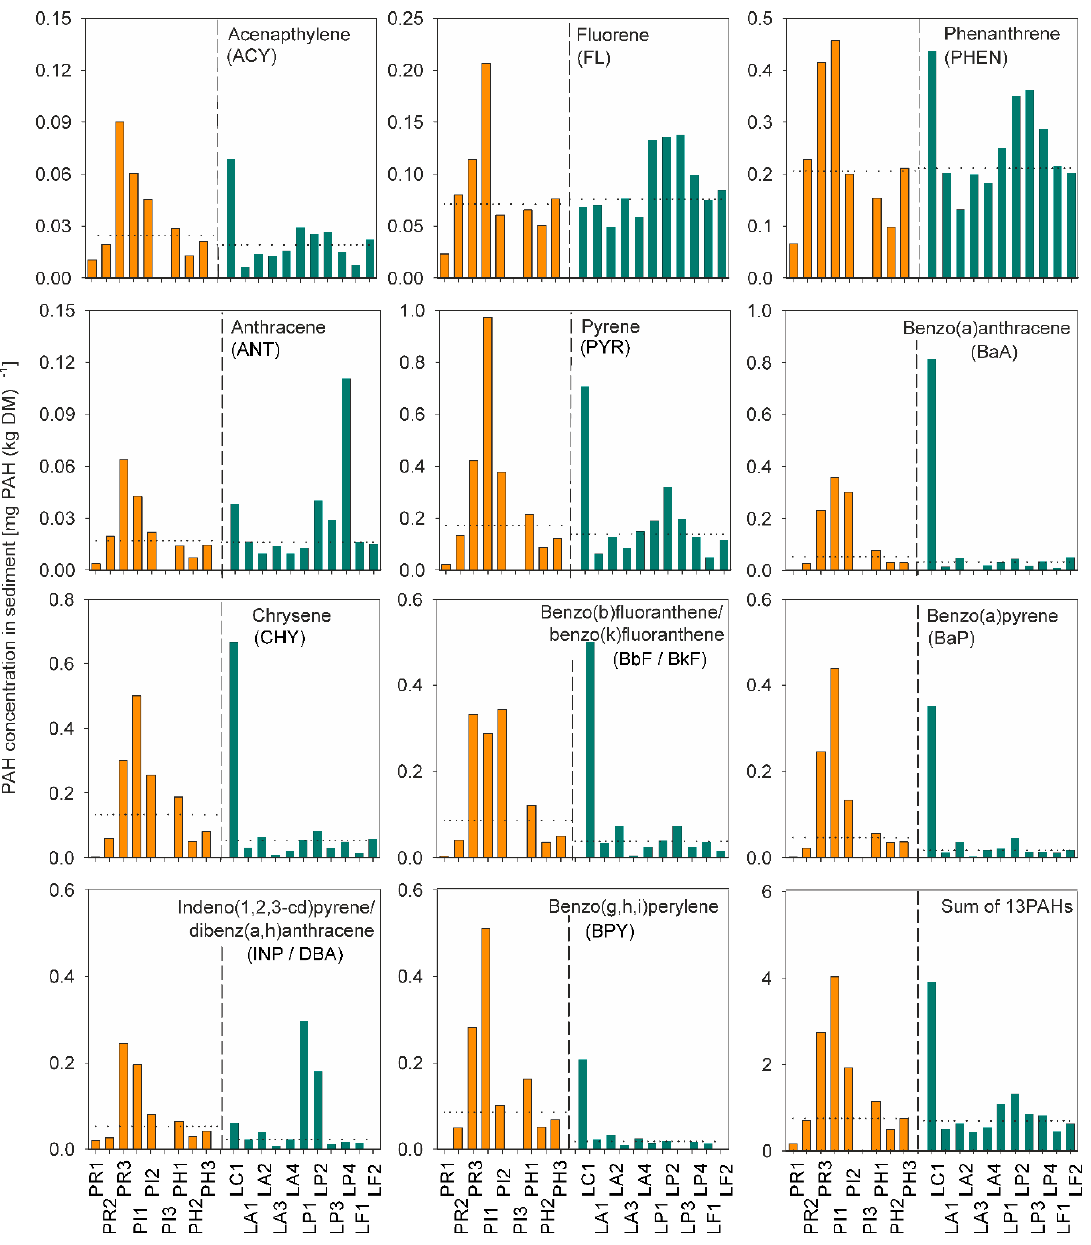
Figure 2. Polycyclic aromatic hydrocarbons (PAH) concentrations in sediments of the SWRPs (orange bars) and the natural, shallow lakes (green bars). The dotted lines represent the overall median concentrations in the SWRPs versus the lakes. No sediment sample was obtained in PI3, because of a raised water level in the sampling period, due to heavy precipitation.